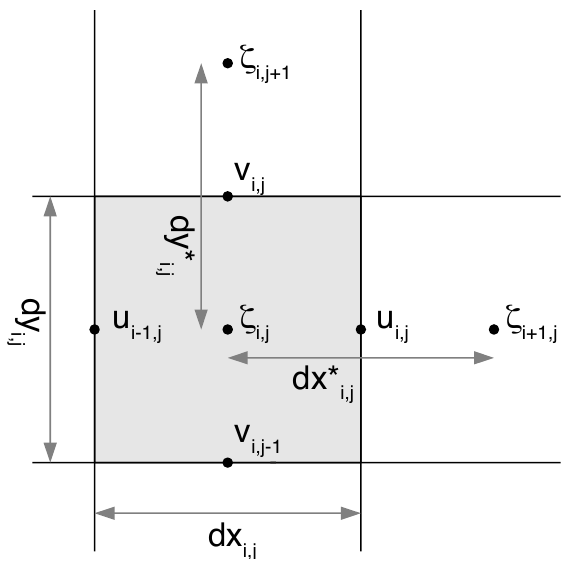
Fig. 1. The Arakawa C grid, showing the relative position of sea level grid points ( ζ ) and the easterly ( u ) and northerly ( v ) components of velocity. The shaded area is the ’grid cell’ surrounding the point ζ i.j . The distances dx i,j etc. are those of Eq. (7).